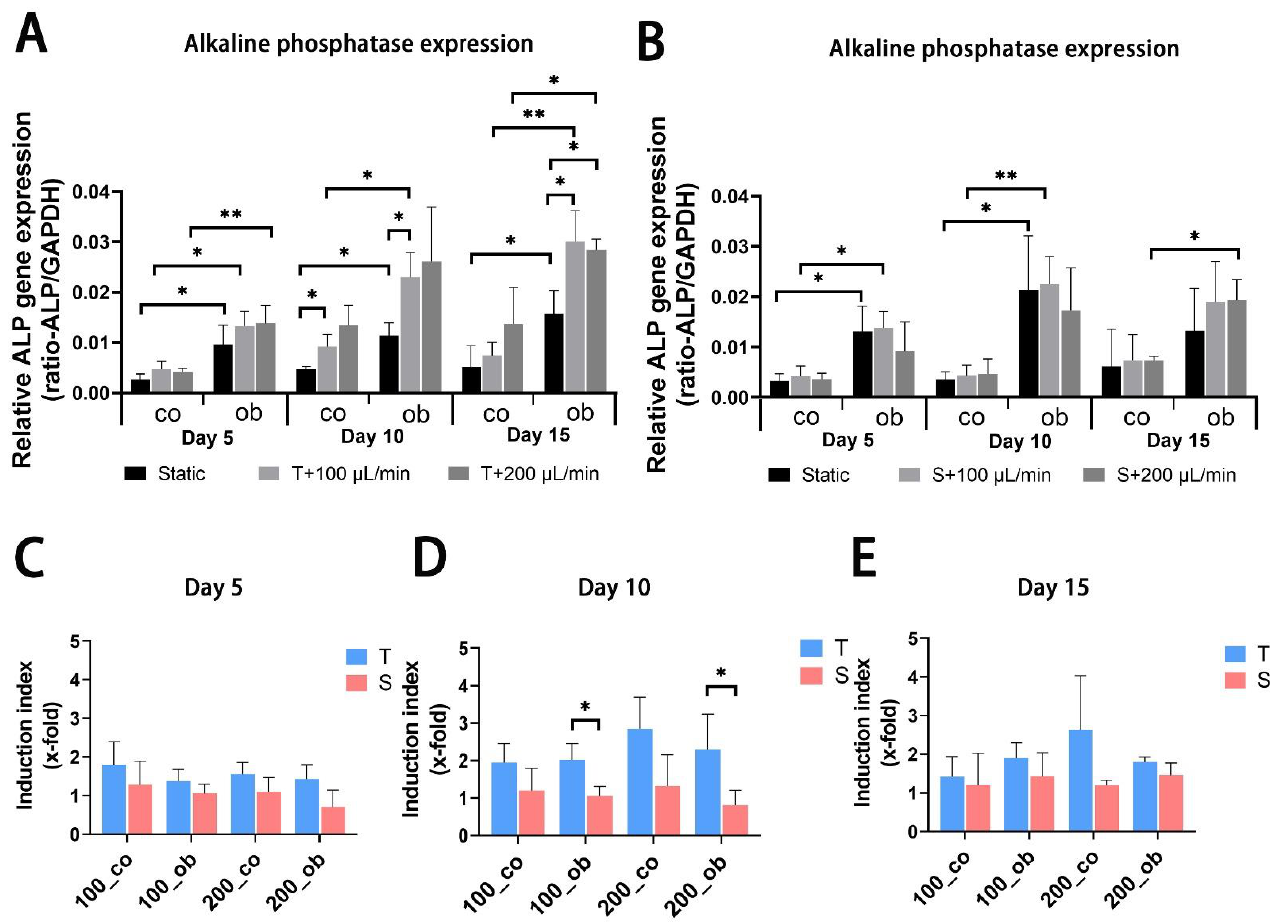
Figure 5. Gene expression levels of alkaline phosphatase (ALPL) in JPC-seeded β -TCP scaffolds after 5 days, 10 days and 15 days of osteogenic differentiation under static or perfusion conditions. mRNA expression levels under ( A ) tangential and ( B ) sigmoidal configuration were quantified and normalized to the housekeeping gene GAPDH. To calculate induction indices, gene expression levels were normalized to untreated (co) JPCs or osteogenically induced (ob) under static conditions. Induction indices of tangential (T) and sigmoidal (S) configuration after ( C ) 5 days, ( D ) 10 days and ( E ) 15 days of culture were calculated. The gene expression and induction values are given as means ± SD. Gene expression levels under different culture conditions (dynamic conditions and static condition) are compared using one-way ANOVA followed by Tukey’s multiple comparisons tests. To compare levels of osteogenic to control condition and induction values between T and S configuration condition, two-tailed Student’s t -test was used (* p < 0.05, ** p < 0.01, ( n = 3 donors)).